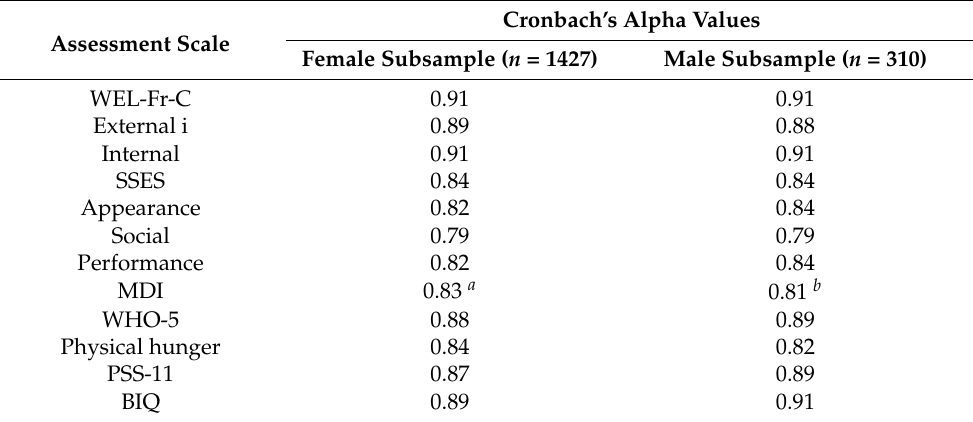
Table 1. Cronbach’s alpha values of the scales used in the female and male